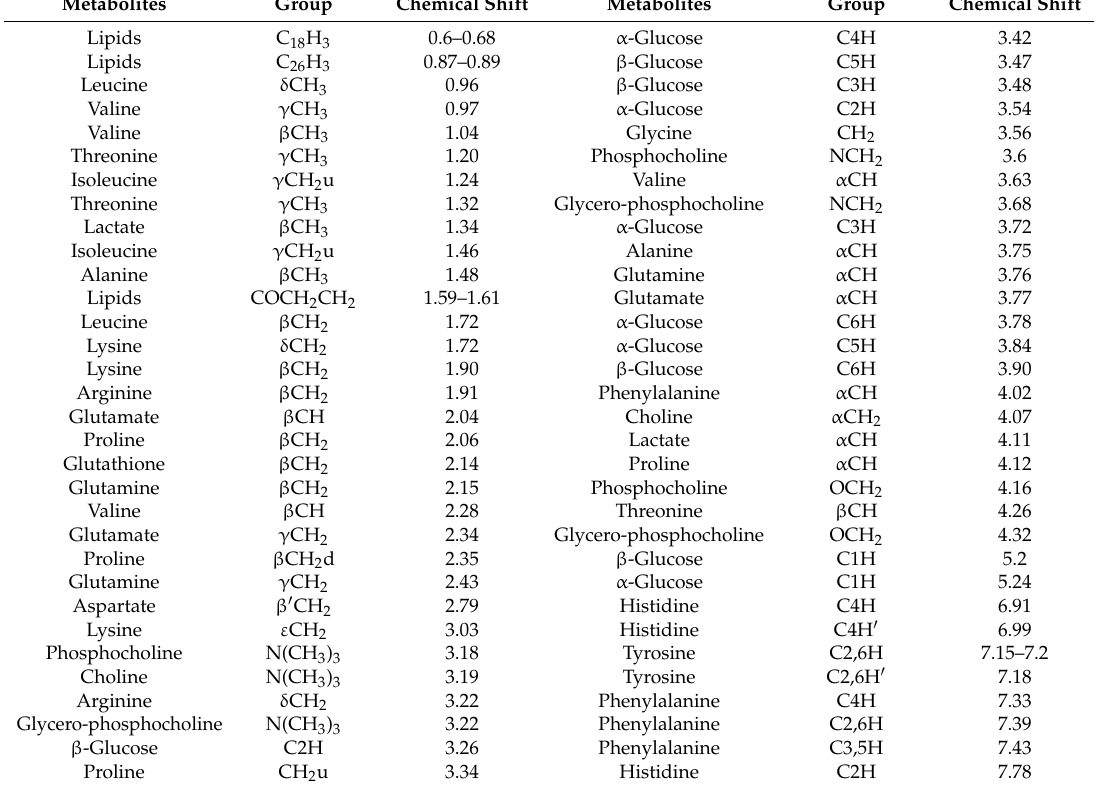
Table 4. List of 1 H chemical shift (ppm) of metabolites found in three breast cancer cells. Metabolites Group Chemical Shift